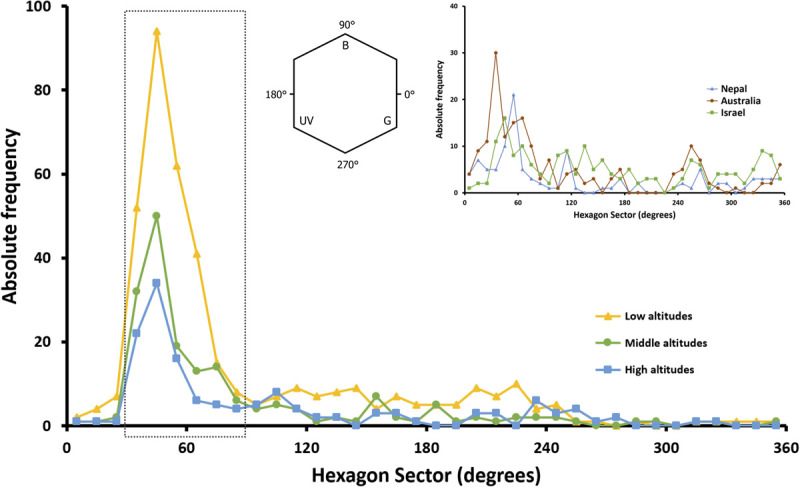
Absolute frequency distribution of floral color loci in 10° sector of bee color hexagon as proposed by Chittka et al. (1994). Distributions for species from low, middle and high altitudes in Taiwan (yellow, green and blue symbols and lines) are plotted, and compared to the global floral color distribution in hexagon color space (inset). The inset figure shows the distribution of species across the Australian continent (brown symbols and line; data from Dyer et al., 2012; Shrestha et al., 2019b), along sub-tropical and sub-alpine transects of the Nepalese Himalayas (blue symbols and line; data from Shrestha et al., 2014) and Israel (green symbols and line; data from Chittka et al., 1994). The dotted rectangle encloses the bee-blue and bee-blue–green sectors of the color space (30°–90°, see inset) where honeybees (Giurfa et al., 1995), bumblebees (Raine and Chittka, 2005) and the stingless bee Tetragonula carbonaria (Dyer et al., 2016) all demonstrate their strongest innate color preference.